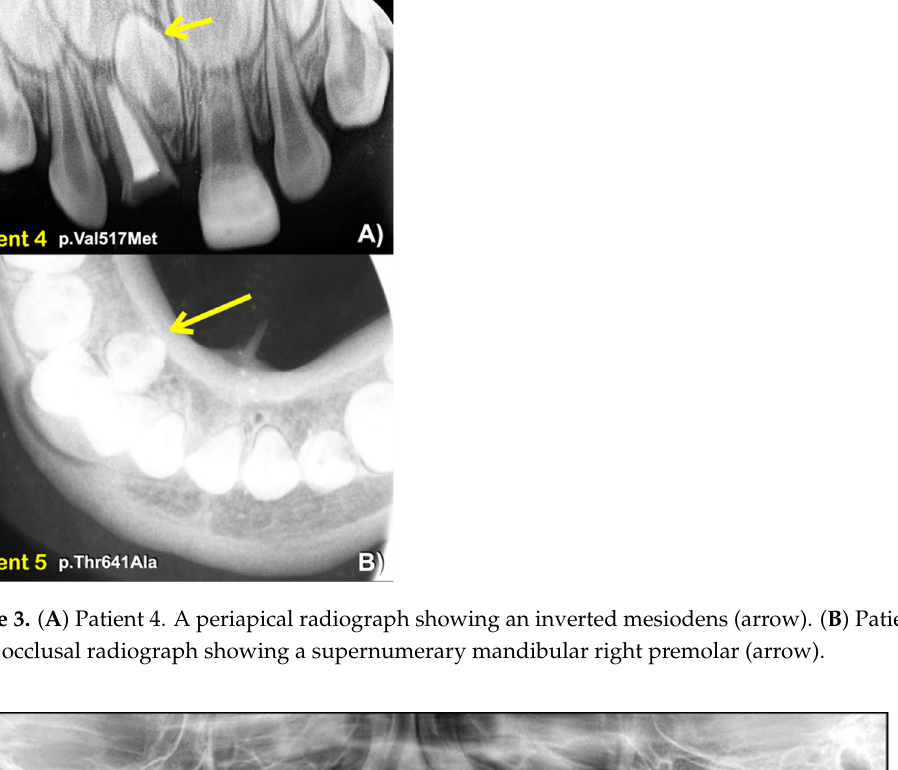
Figure 5. Patient 7. ( A ) Torus palatinus (arrow). ( B ) Torus mandibularis (arrowheads). Supernumer- ary left mandibular premolar (arrow). ( C ) Panoramic radiograph showing supernumerary mandib- ular premolars (arrows). Maxillary permanent molars with unseparated roots (asterisks). Short roots of the mandibular right second permanent molar (star). The heterozygous missense variant c.1603C>T; p.Arg535Cys was identi fi ed in patient 1, who had a mesiodens and torus palatinus. According to gnomAD, this variant is rare, with a global allele frequency of 0.0001712. It has not been reported in the South Asian population. Its allele frequency in the East Asian population is 0.002164. According to the T-Rex database, this allele was found in 4 out of 2184 alleles (allele frequency = 0.0018315 or 0.18%). The allele frequency of this variant in the study group (0.409836%) is higher